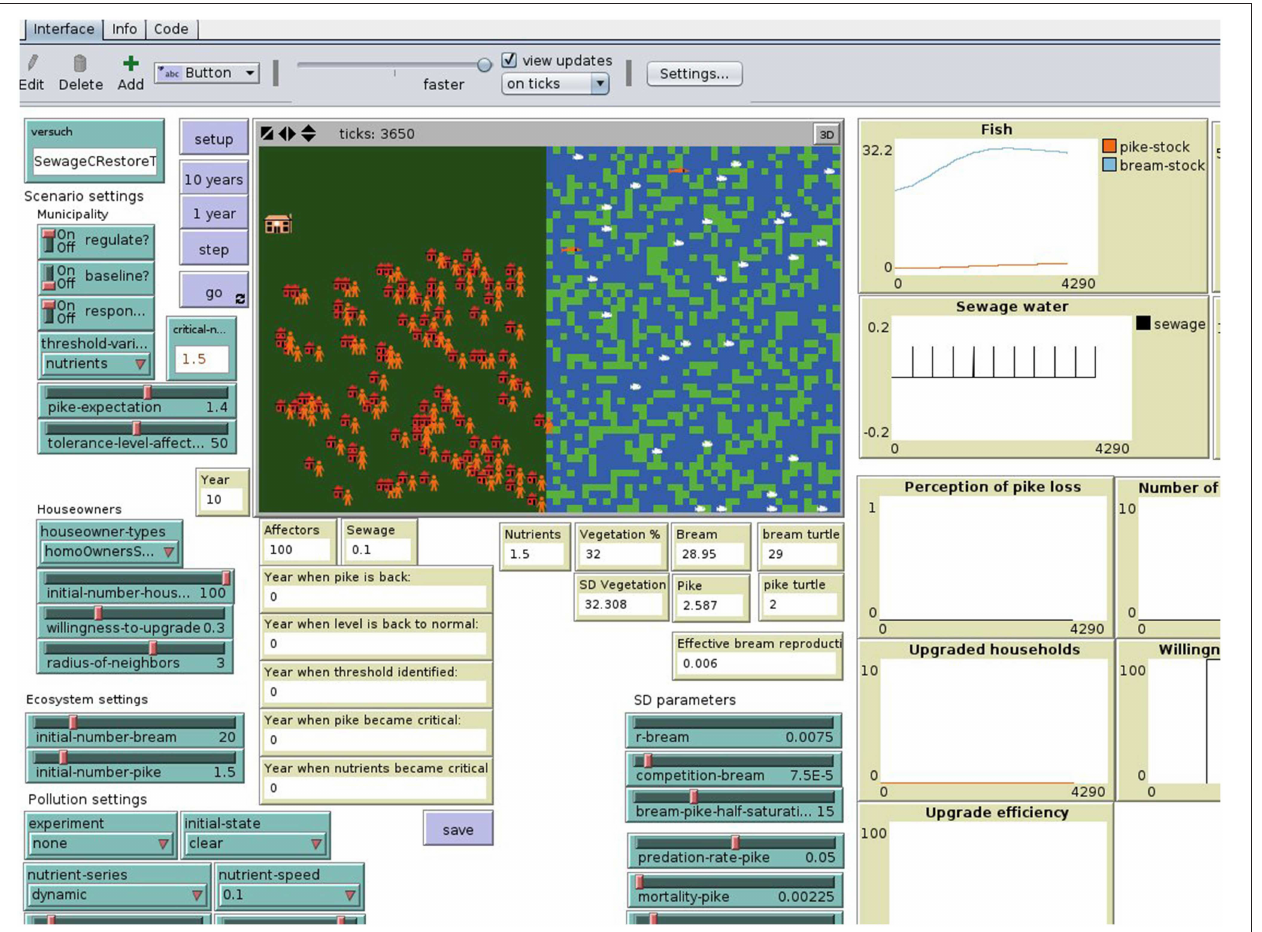
FIGURE 3 | Part of the graphical interface from our “LimnoSES” implementation in NetLogo showing in the main visualization panel house owner agents on the left side and representative agents for the fish stocks on the right side. Buttons, sliders, information boxes and diagrams are used for testing single scenarios before they were executed in a batch mode for the